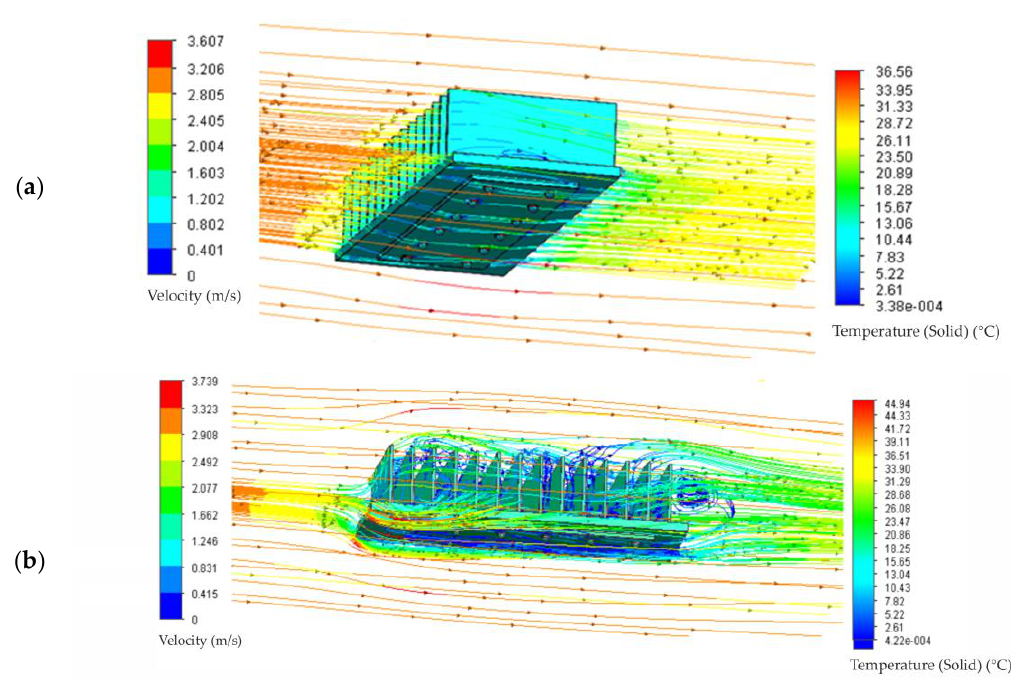
Figure 19. Temperature distribution and airflow trajectory for the investigated LED panel for T a = 0 °C and v = 3 m/s: ( a ) airflow on the radiator’s side and ( b ) airflow in front of the radiator.